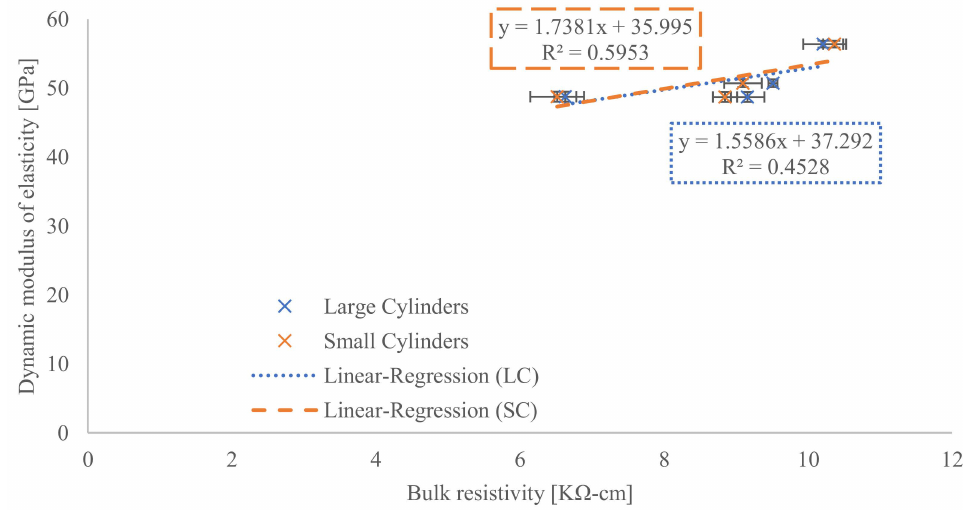
Figure 9. Linear regression analysis of the relationship between bulk electrical resistivity and dynamic modulus of elasticity (LC = Large Cylinders, SC = Small